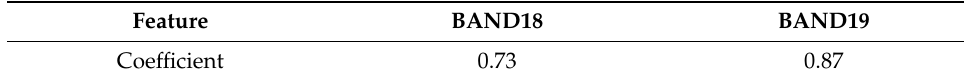
Table 12. Interaction characteristic coefficients of vegetation.